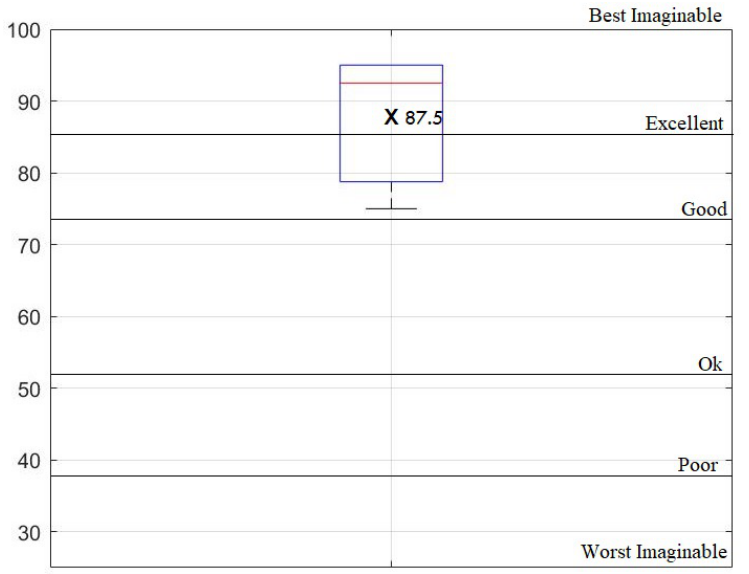
Figure 3. Boxplot of System Usability Scale outcomes, overlapped with the 7-point adjective SUS scale interpretation